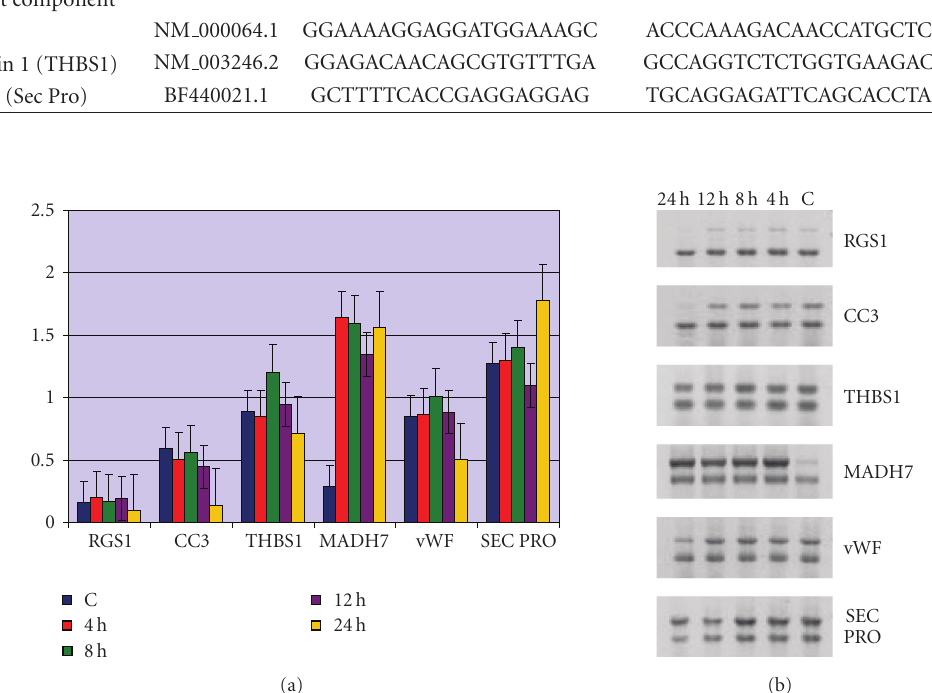
Figure 1: Ionizing radiation-induced gene expression in Jurkat cells. (a) The expression ratios of various genes at 4-, 8-, 12-, and 24-hour time points compared to unirradiated sham control. (b) Agarose gel images of relative quantative RT-PCR for various genes. In all cases, the upper gel band represents gene-specific amplification and the lower gel band indicates the relative amplification of β -actin internal standards.